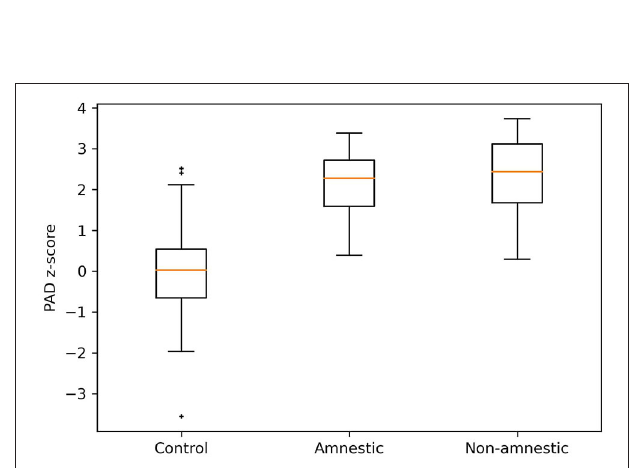
FIGURE 5 | PAD z-scores distribution for controls, amnestic, and non-amnestic EOAD patients. A Kruskal–Wallis test was applied to these groups with a p < 0.001. Using Cliff’s delta, we showed that there was an effect size between controls and non-amnestic population ( d = 0.91), controls and amnestic population ( d = 0.90), and non-amnestic and amnestic population ( d = 0.22). PAD, predicted age difference. †, ‡; represent the outliers of the